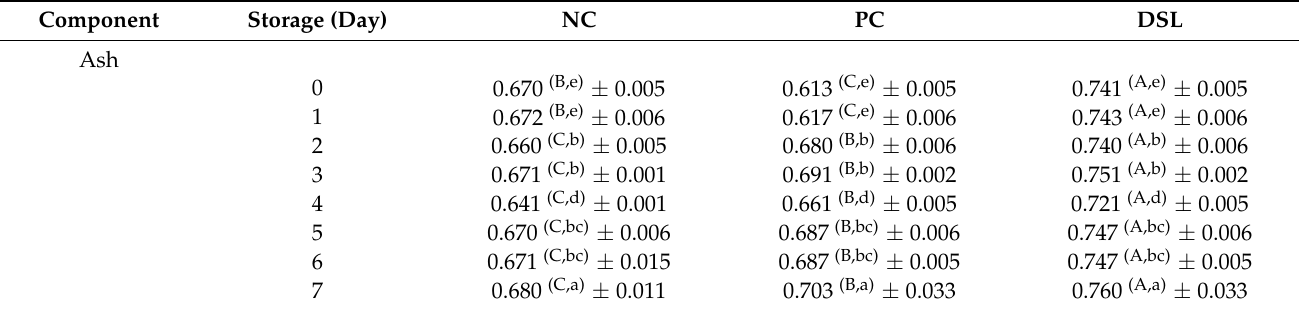
Table 2. Chemical composition of laban drinks during cold